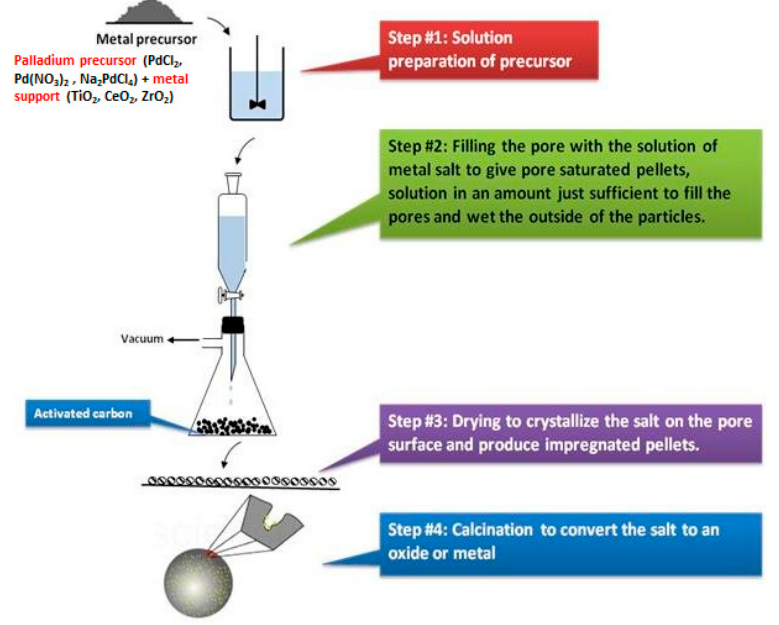
Figure 16. The wetness impregnation